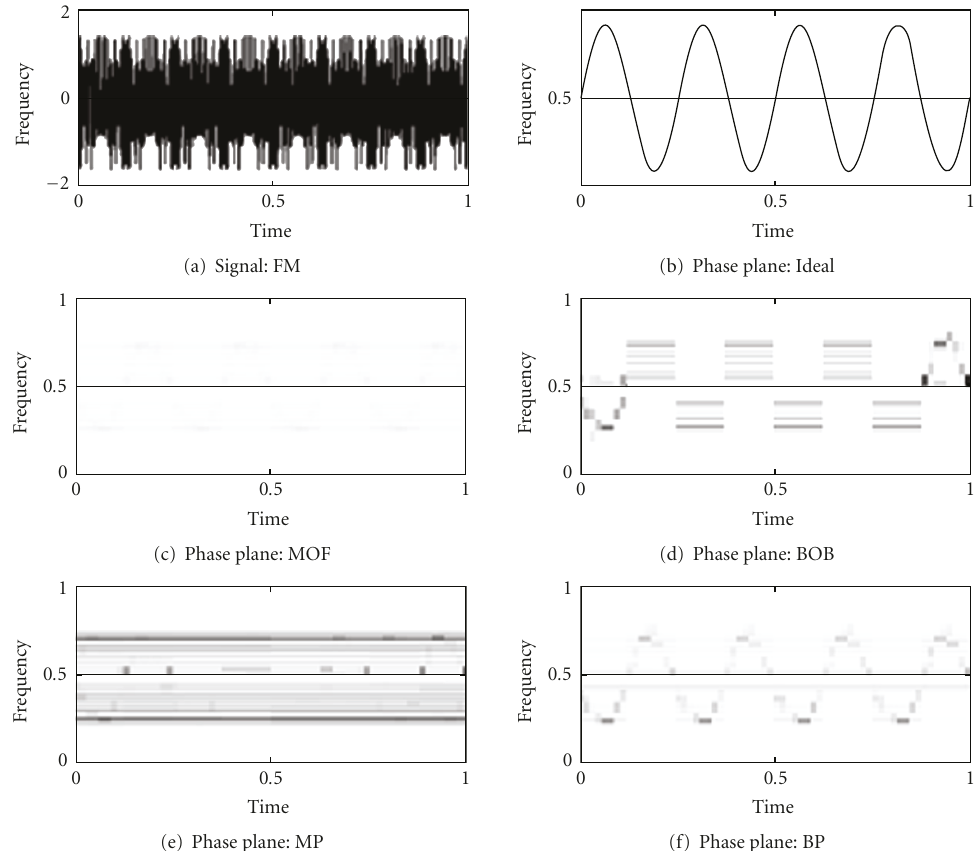
Figure 25: Analyzing the FM cosine signal with a cosine packet dictionary using MOF, BOB, MP, and BP methods (adopted from [185]). considered by Rilling and Flandrin [208]. The signal in the top row is decomposed by the EMD, resulting in the three IMFs listed below and six others that are not displayed since they are almost zero (they contain less than 0.3% of the total energy). The t-f analysis of the signal (top left of the four bottom diagrams) reveals three t-f signatures that overlap in both time and frequency, thus forbidding the components to be separated by any nonadaptive filtering technique. The t-f signatures of the first three IMFs are extracted by EMD evidence that these modes e ffi ciently capture the three- component structure of the analyzed signal. All TFDs are reassigned spectrograms in this